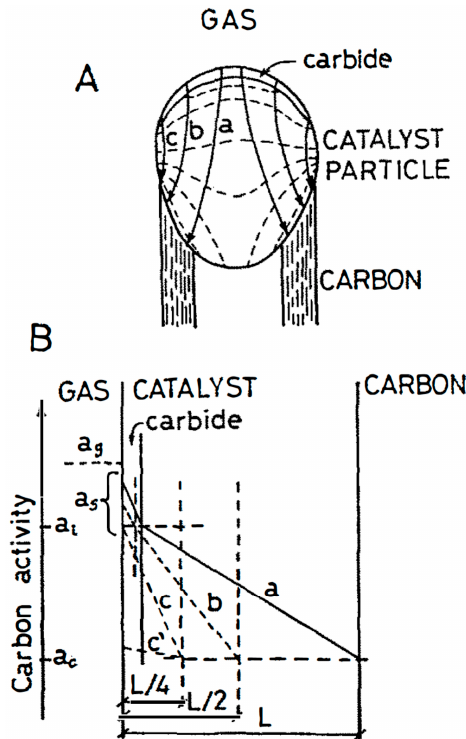
Figure 3. Carbon bulk diffusion through the catalyst bulk during CNT growth: ( A ) possible iso-concentration lines (dashed lines) and lines of flux (arrows) through a catalyst particle. ( B ) Carbon concentration/activity profiles through the catalyst for the three different diffusion paths. Reprinted from [5] with permission from Elsevier.